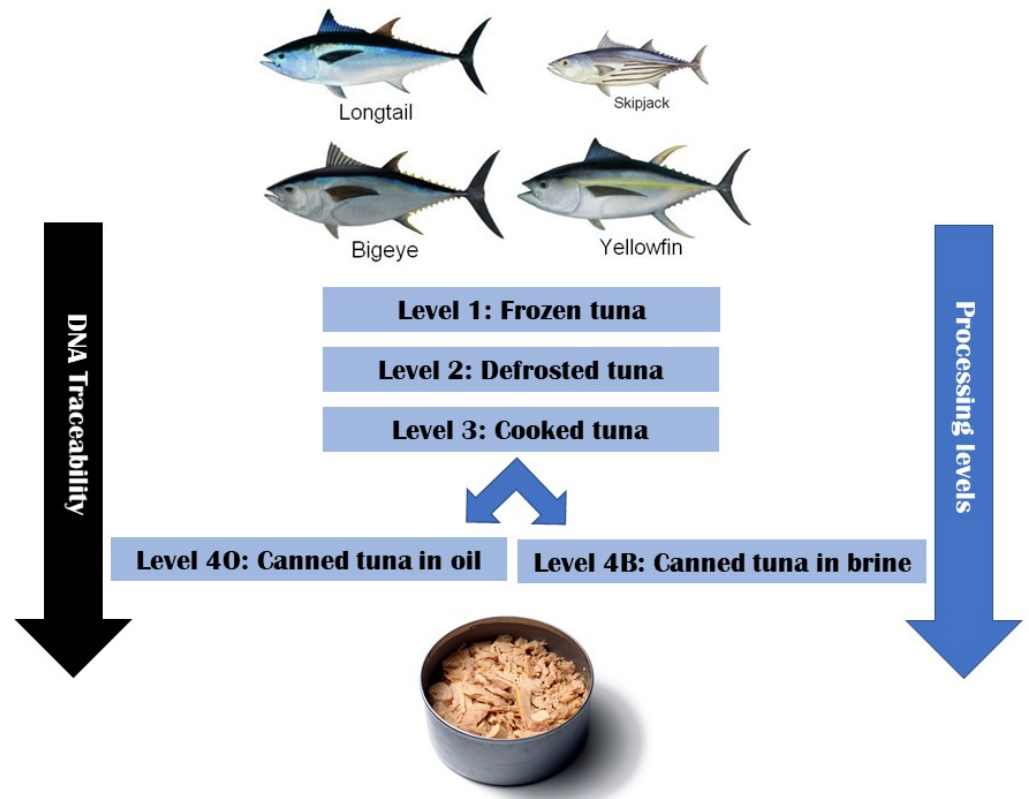
Figure 1. A schematic of the sampling design for the four target tuna species at four processing levels along the tuna canning chain. Each specimen was morphologically identified at the tuna canneries and then genetically identified after having been subjected to each processing level (L1 – L4).